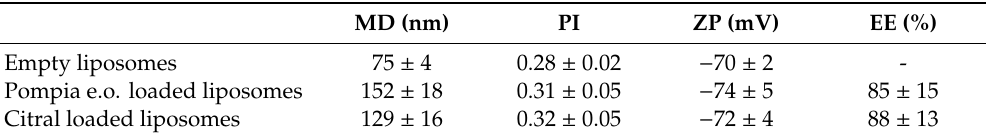
Table 2. Mean diameter (MD), polydispersity index (PI), zeta potential (ZP), and entrapment e ffi ciency (EE) of empty, pompia essential oil-, and citral loaded liposomes. Mean values ± standard deviations were obtained from at least six replicates.